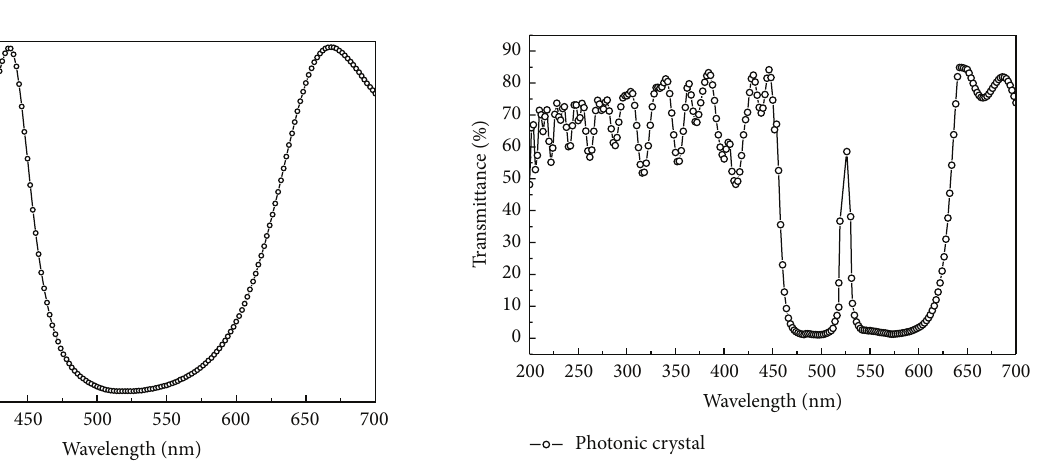
Figure 9: The transmitted spectrum of one-dimensional photonic